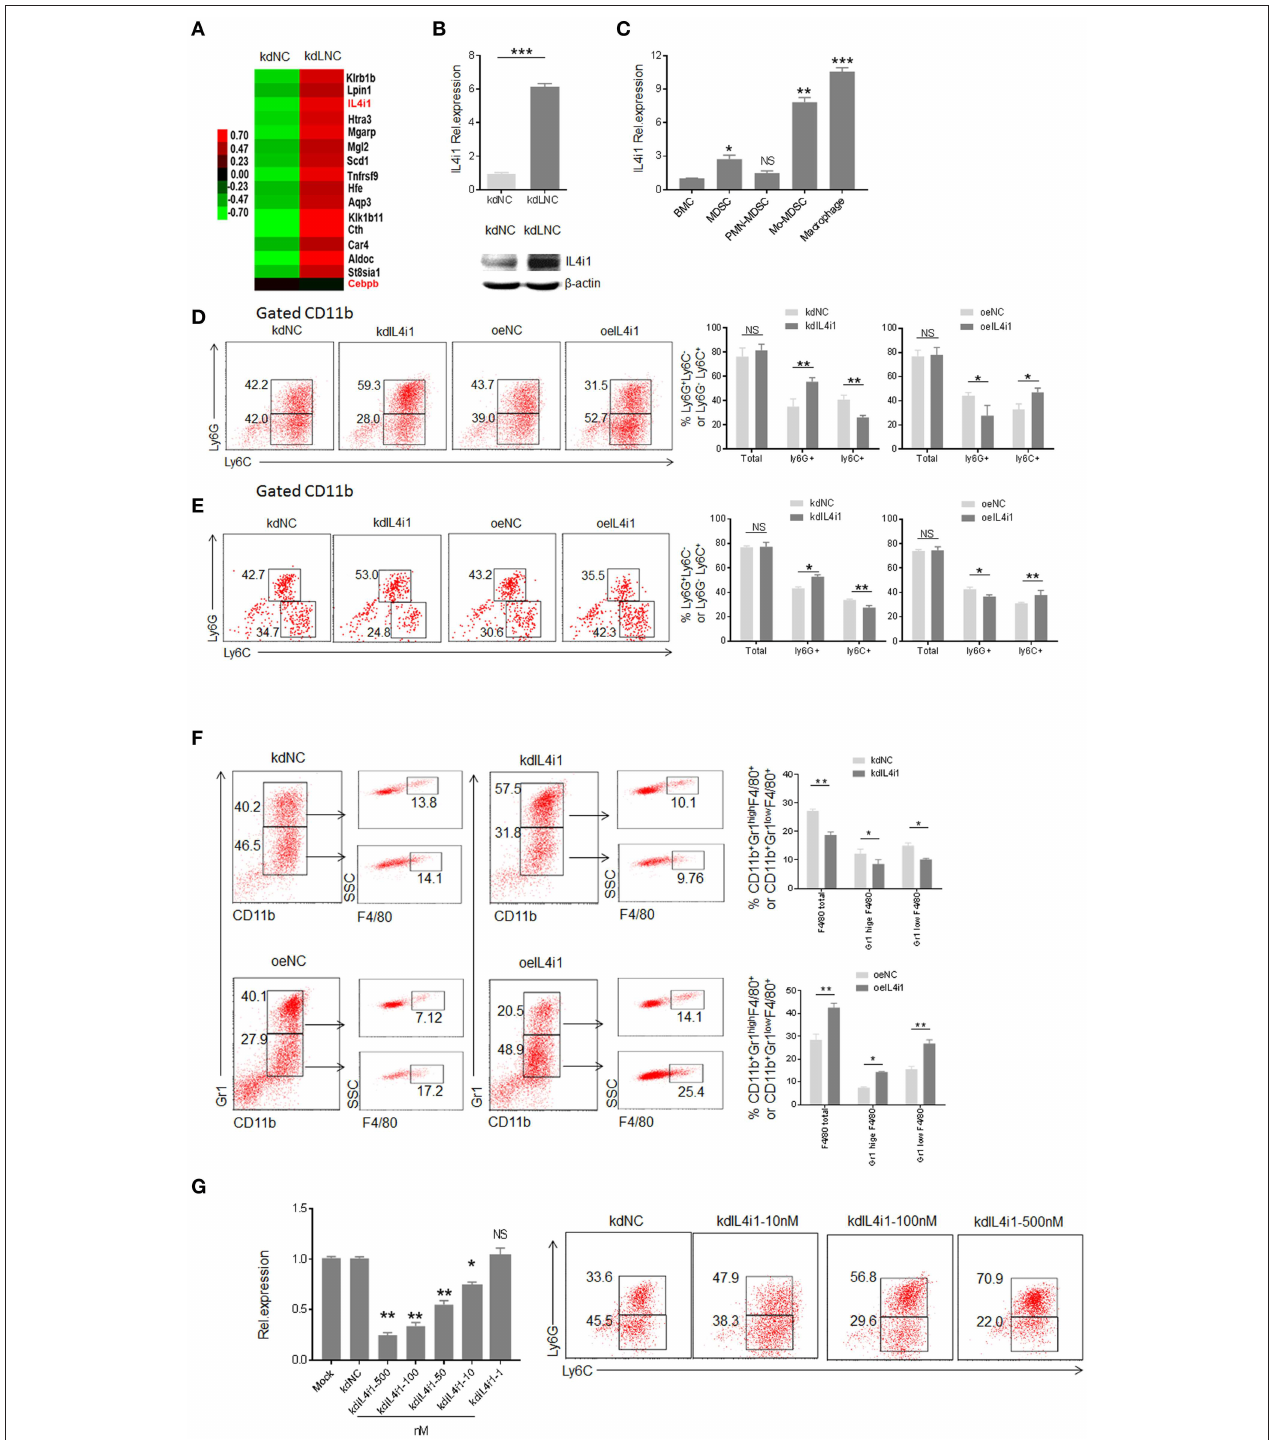
FIGURE 4 | lnc-C/EBP β mediated differentiation of MDSCs depends on IL4il. (A) Gene expression in lnc-C/EBP β knockdown treated MDSC. (B) QRT-PCR (upper) and immunoblotting (lower) of IL4il in lnc-C/EBP β knockdown MDSCs. (C) QRT-PCR of IL4i1 in the MDSC subsets isolated from WT mice bearing B16 tumor.